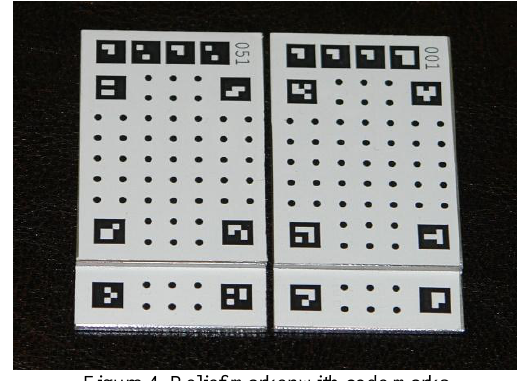
Figure 4. Relief marker with code